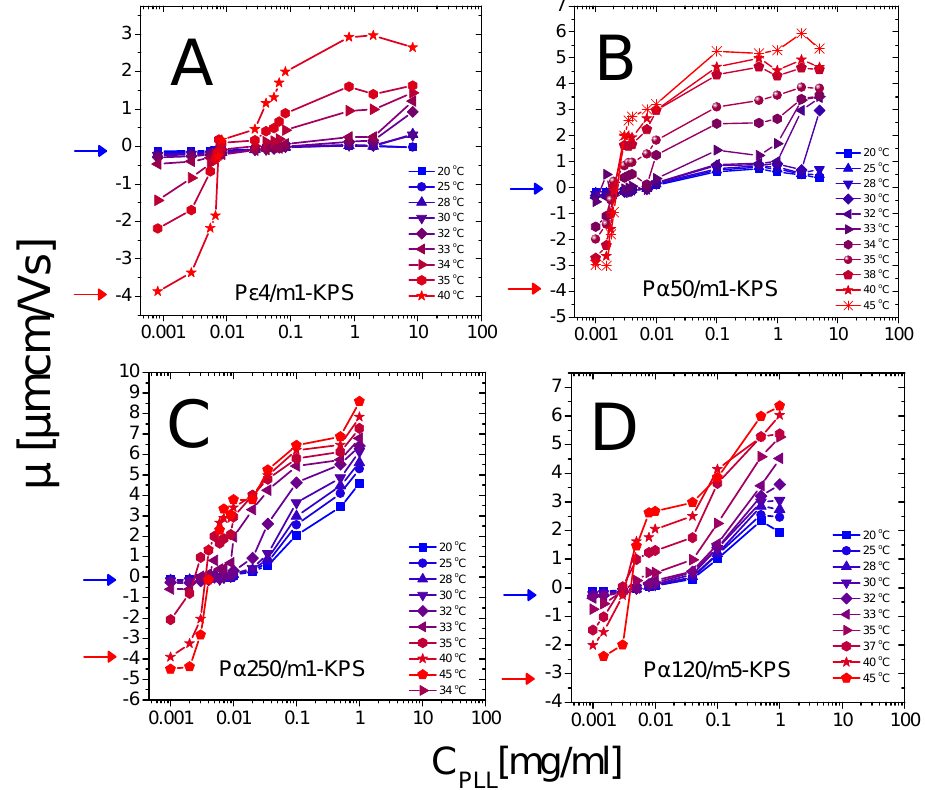
Figure 5. Electrophoretic mobility in function of C PLL for P ε 4/m1-KPS (Panel A ), P α 50/m1-KPS (Panel B ), P α 250/m1-KPS (Panel C ) and P α 120/m5-KPS (Panel D ) mixtures, and selected tempera- tures as indicated in the panels. Mobilities of bare microgels at 20 ◦ C (blue arrows) and 40 ◦ C (red arrows) are also shown for